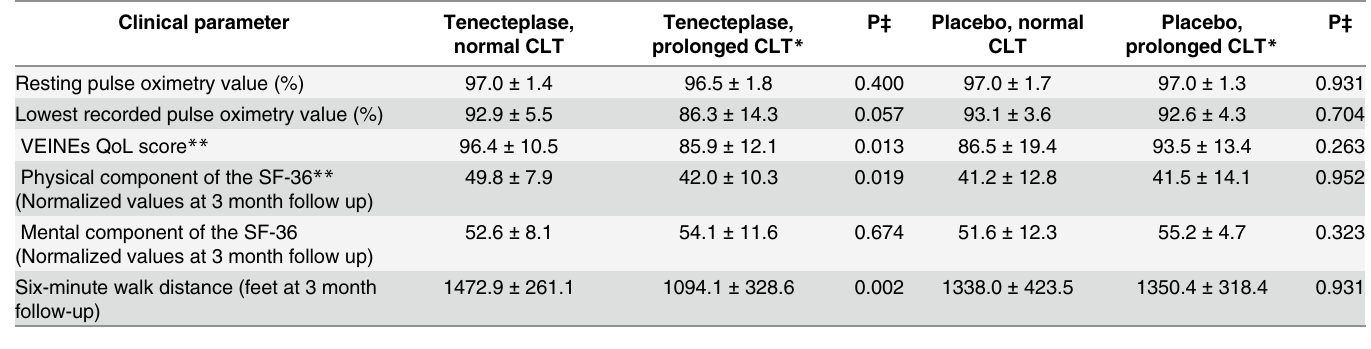
Table 3. Clinical outcomes three months after pulmonary embolism based upon clot lysis time at diagnosis.